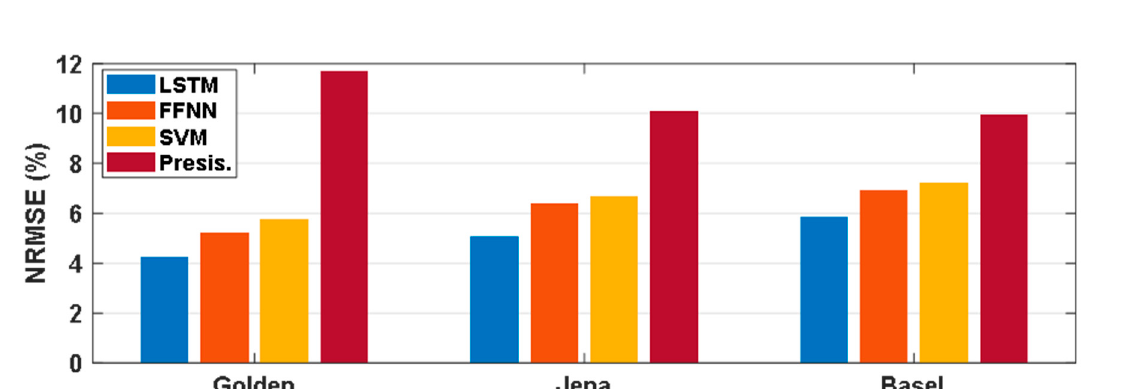
Figure 7. The average NRMSE at the three locations for each model. Table 5. The obtained results for the proposed hybrid model and other models.